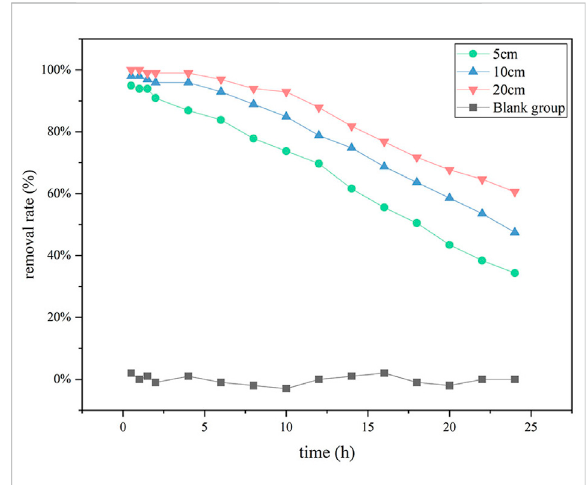
FIGURE 2 Dynamic phosphorus removal effect of ceramsite loaded with nano-iron of different thickness.